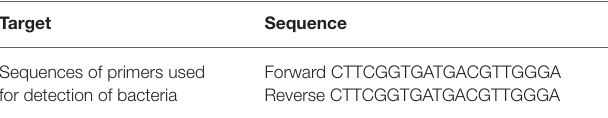
TABLE 2 | Sequence of primers used for detection of bacteria. Target Sequence Sequences of primers used for detection of